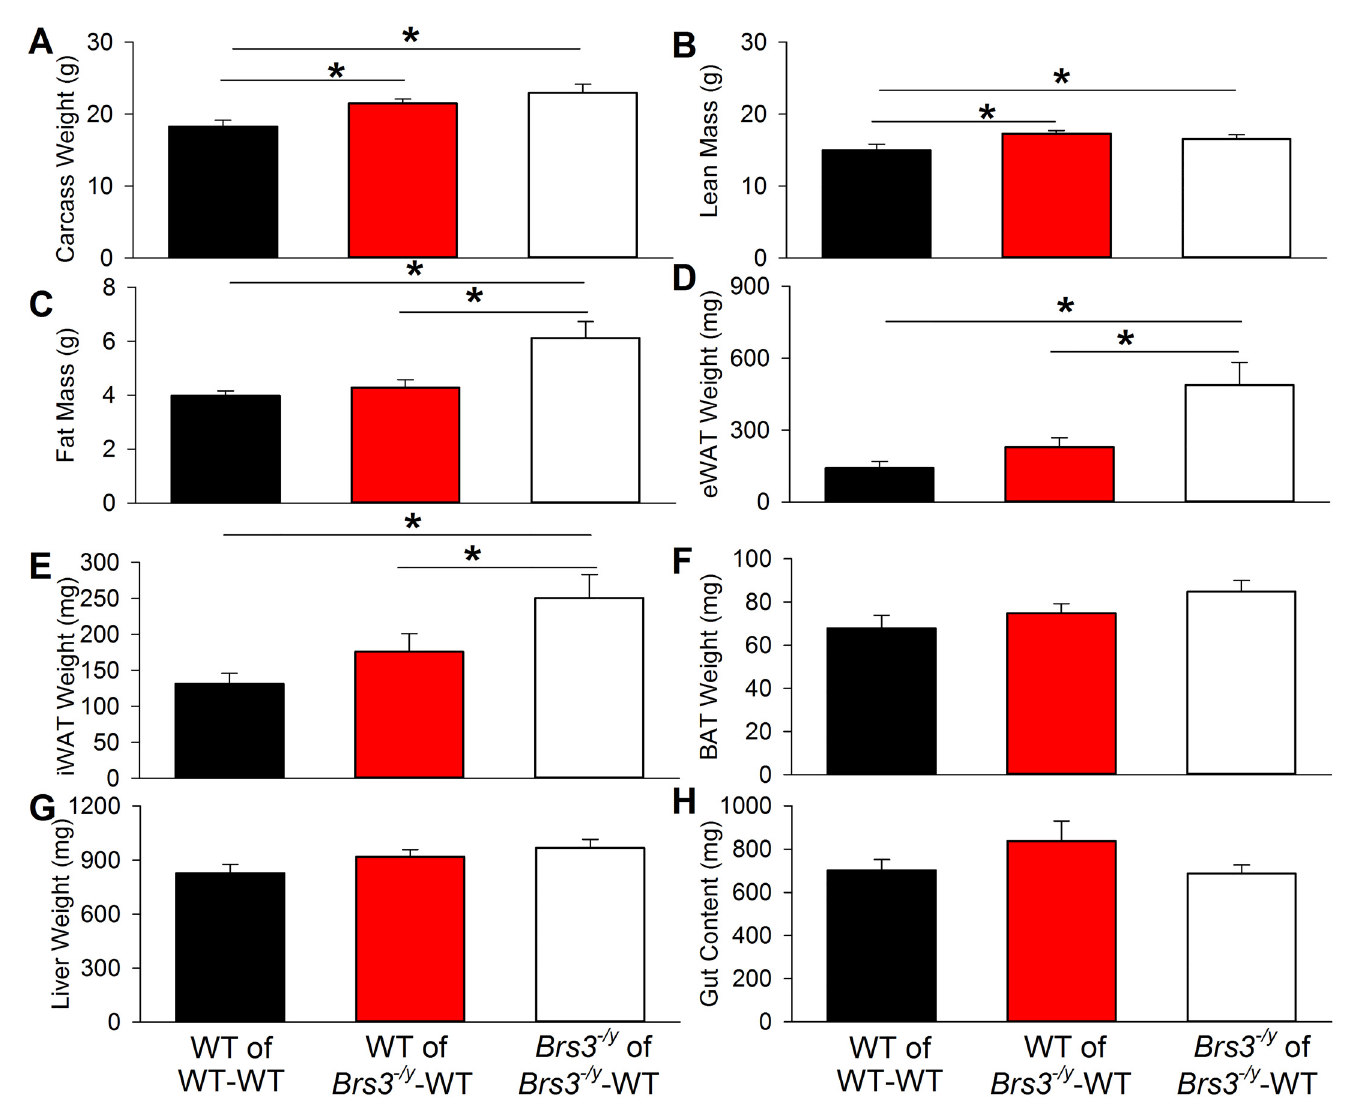
Fig 3. Effects of parabiosis at 9 weeks. (A) Body weight, (B) lean mass, (C) fat mass, (D) epididymal white adipose tissue (eWAT) weight, (E) inguinal white adipose tissue (iWAT) weight, (F) brown adipose tissue (BAT) weight, (G) liver weight, and (H) gut content. Data are mean ± SEM; N = 8 – 14 mice/ group. * P <